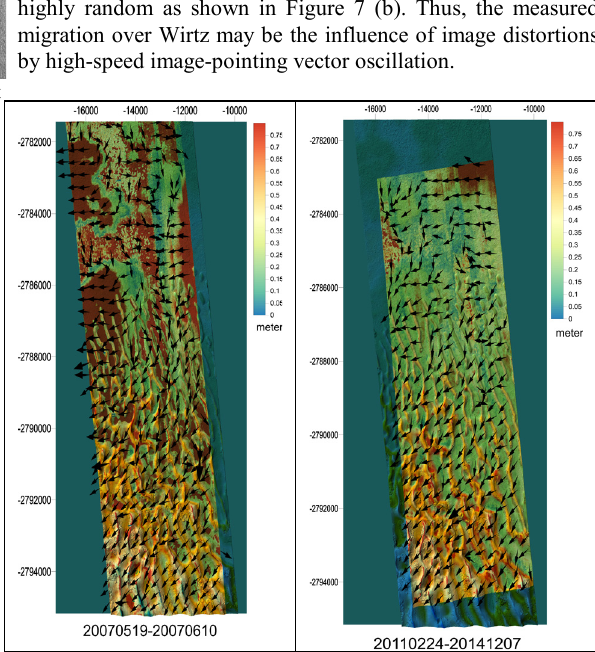
Figure 5 . Traced dune migrations over